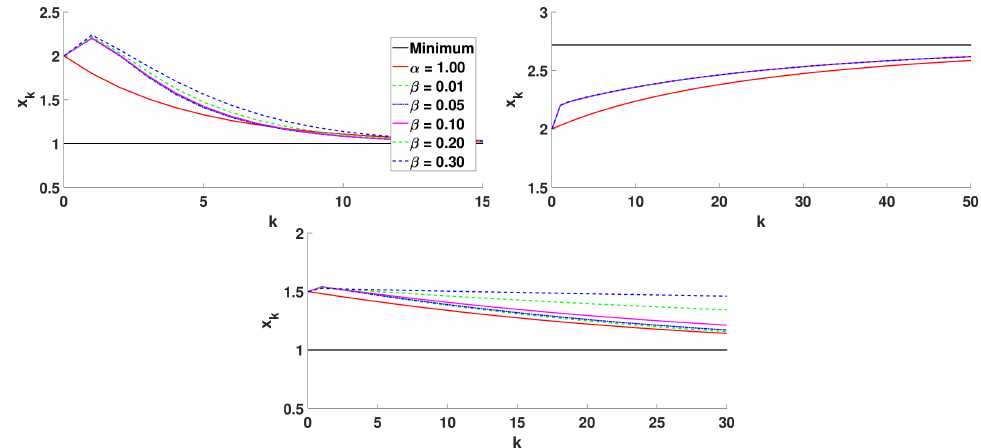
Figure 5. Algorithm 1 with α ( x ) = 1 − tanh ( β J ( x )) and different values of β